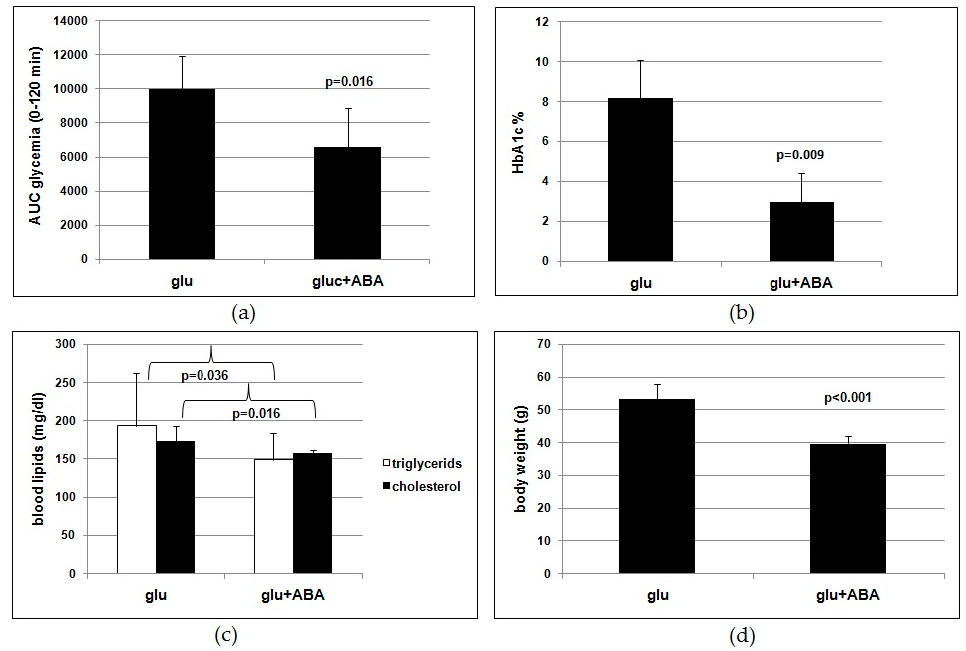
Figure 3. Low-dose synthetic ABA improves metabolic parameters in mice fed a high-glucose diet. Seven-week-old male CD1 mice (nine/group) were fed for 4 months a high-glucose diet containing 1 g/Kg BW glucose (administered with the drinking water) without (controls) or with ABA at approximately 1 µg/Kg BW. At the end of the study, fasting HbA1c, lipidemia, and body weight were measured and an OGTT was performed. ( a ) AUC of glycemia after OGTT, ( b ) HbA1c, ( c ) lipidemia, ( d ) body weight. Mean ± SD values are shown. p values by unpaired, two-tailed t -test.